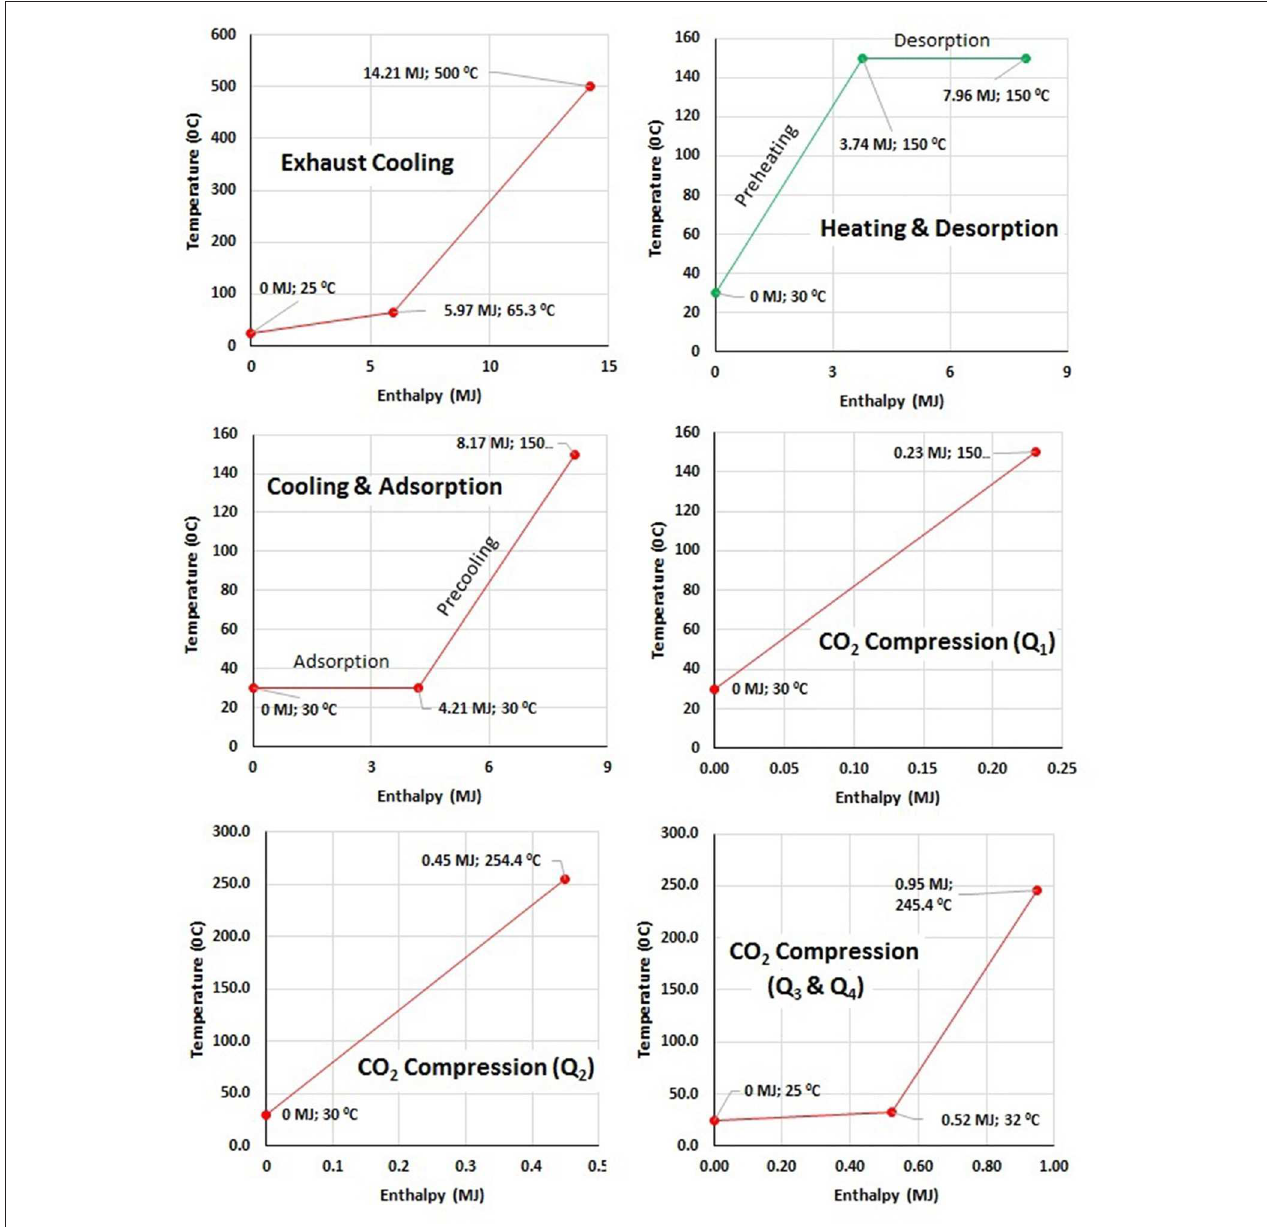
FIGURE 4 | Enthalpy-temperature profiles for exhaust cooling, adsorption cooling, desorption heating and CO 2 compression, and liquefaction for 1l